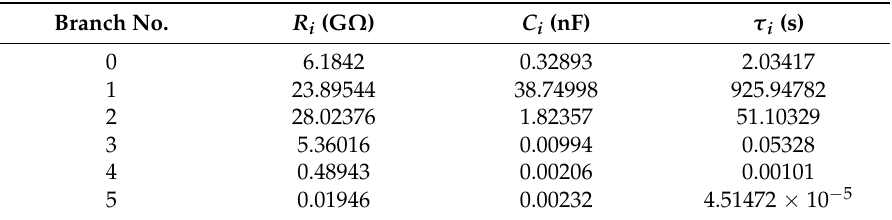
Table 3. The identified resistance and capacitance in EDM at 70 ◦ C. Branch